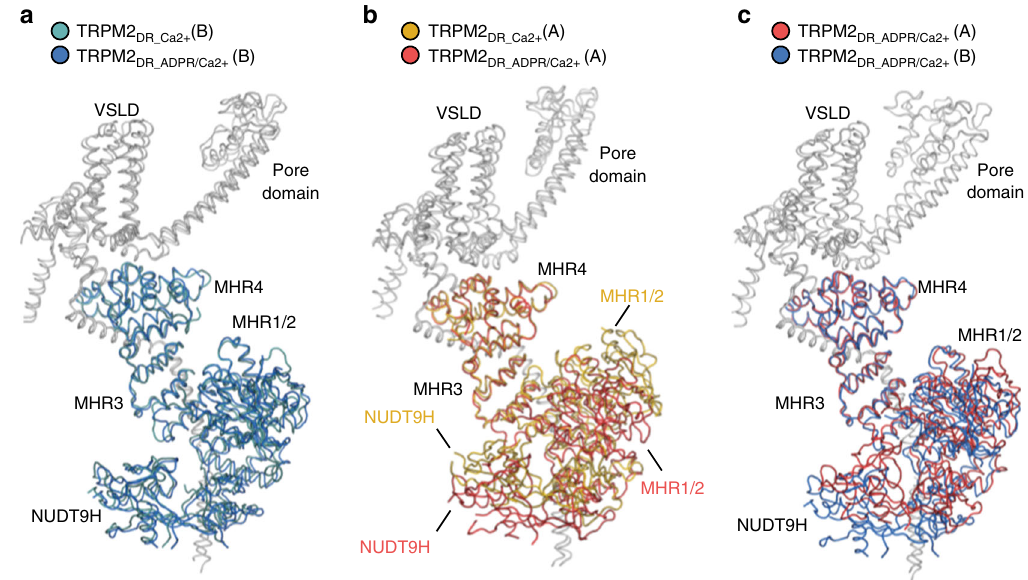
Fig. 5 Addition of ADPR converts protomer con fi gurations at the CD. Cartoon representations showing structural alignment of protomer B in the TRPM2 DR_Ca2 + structure (teal) and protomer B in the TRPM2 DR_ADPR/Ca2 + structure (blue) ( a ), protomer A in the TRPM2 DR_Ca2 + structure (yellow) and protomer A in the TRPM2 DR_ADPR/Ca2 + structure (red) ( b ), and protomer A (red) and protomer B (blue) in the TRPM2 DR_ADPR/Ca2 + structure ( c ). Protomers are aligned at MHR4 domains. TMDs and C-terminal domains are colored in